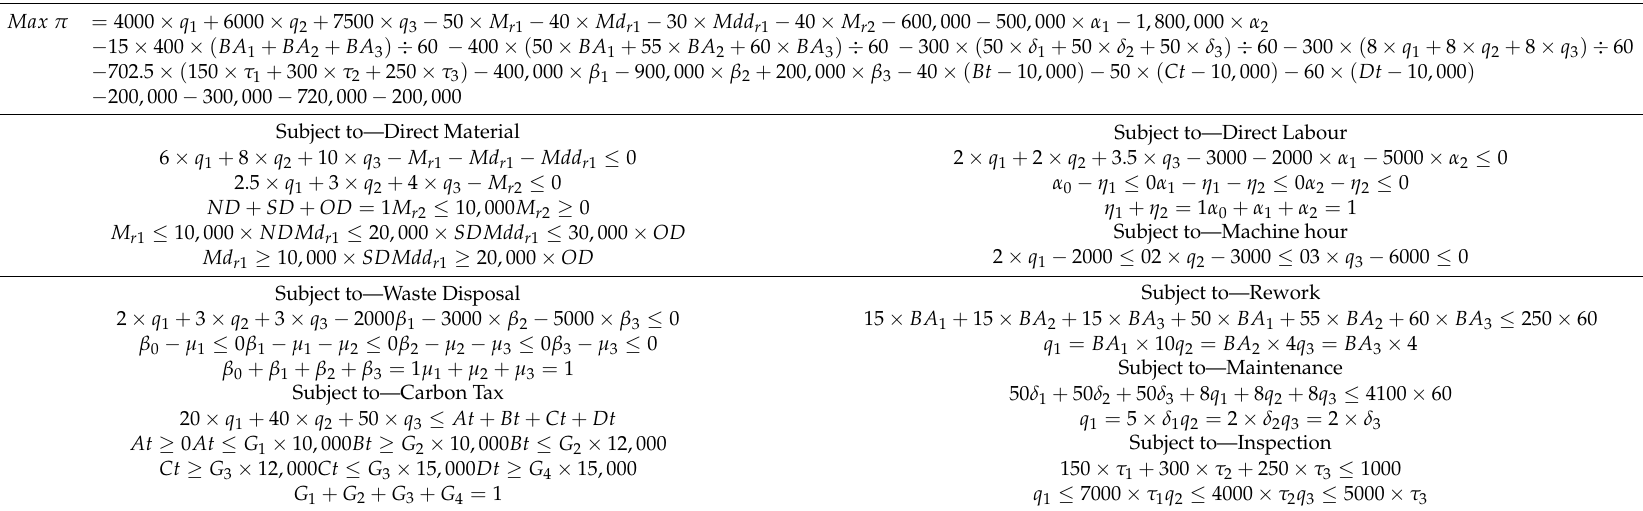
Table A3. The quality management decision model for current capacity with carbon tax (Scenario